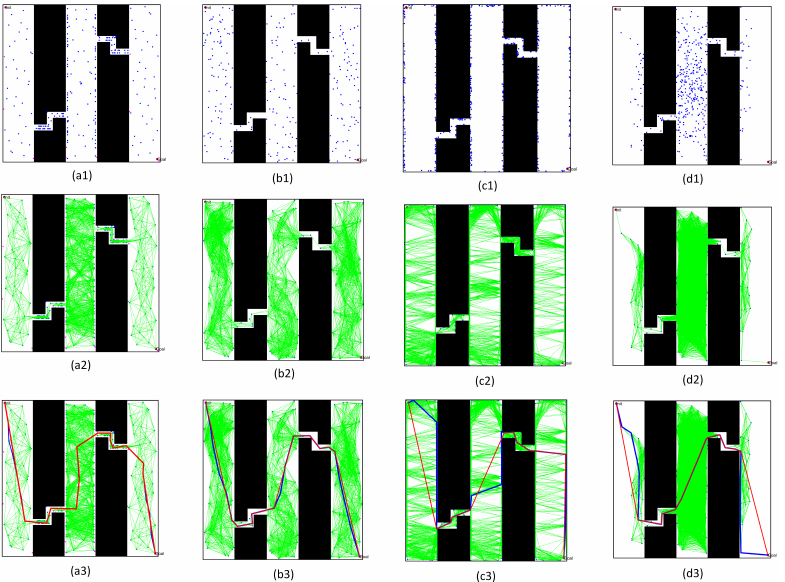
Figure 25. Results of various PRM algorithms in the environment with two narrow channels: ( a1 – a3 ) Based on the sampling method proposed in this paper; ( b1 – b3 ) based on random sampling method; ( c1 – c3 ) based on Gaussian sampling method; and ( d1 – d3 ) based on Bridge sampling method.